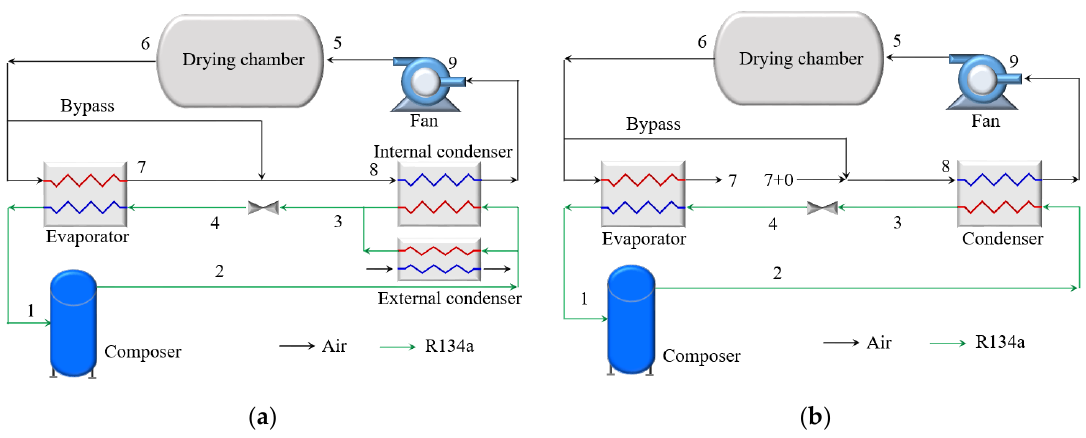
Figure 1. Schematic diagram of the system showing air and refrigerant cycles for: ( a ) The CHPD, ( b ) the HPDU.